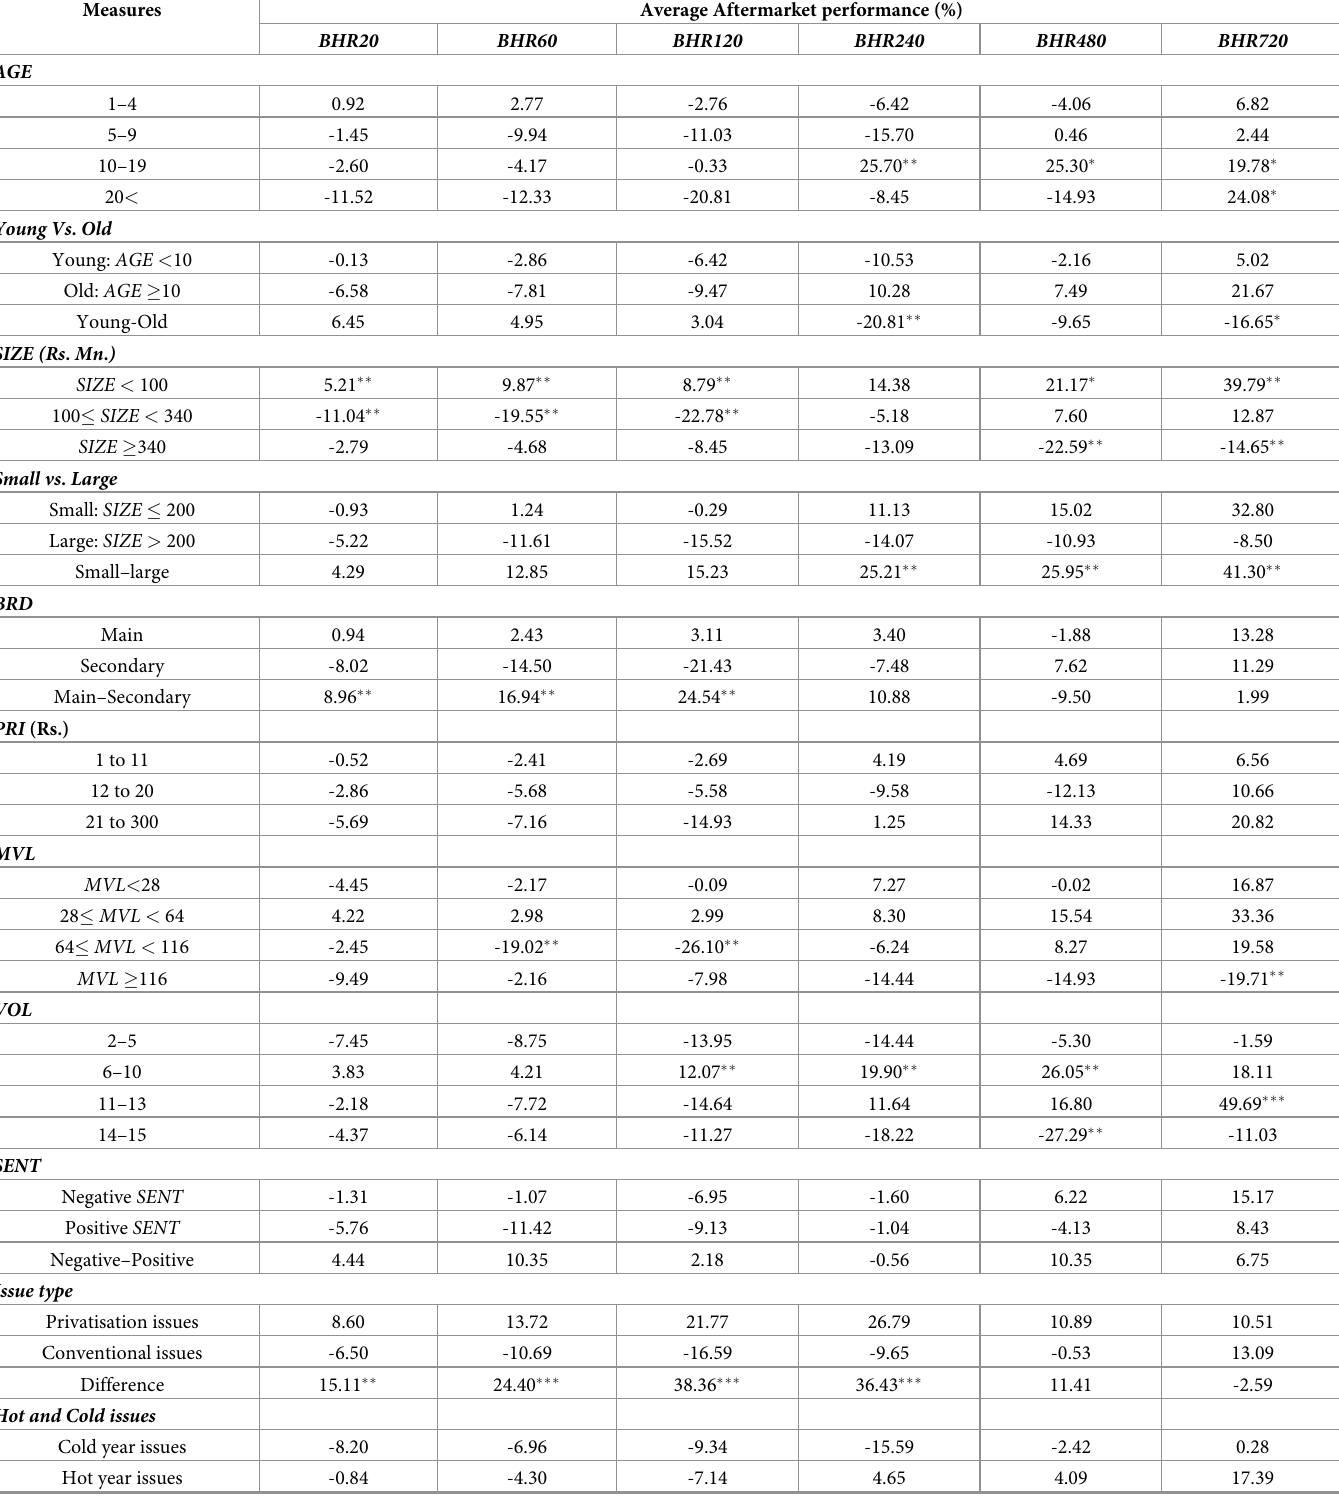
Table 4. Aftermarket performance categorized by individual measures.